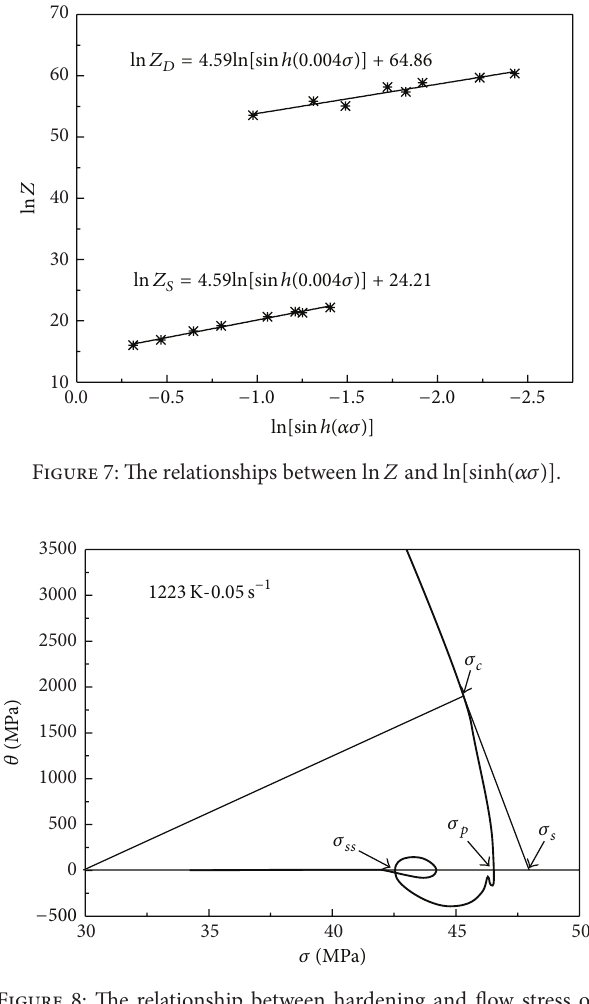
Figure 8: The relationship between hardening and flow stress of TA15.